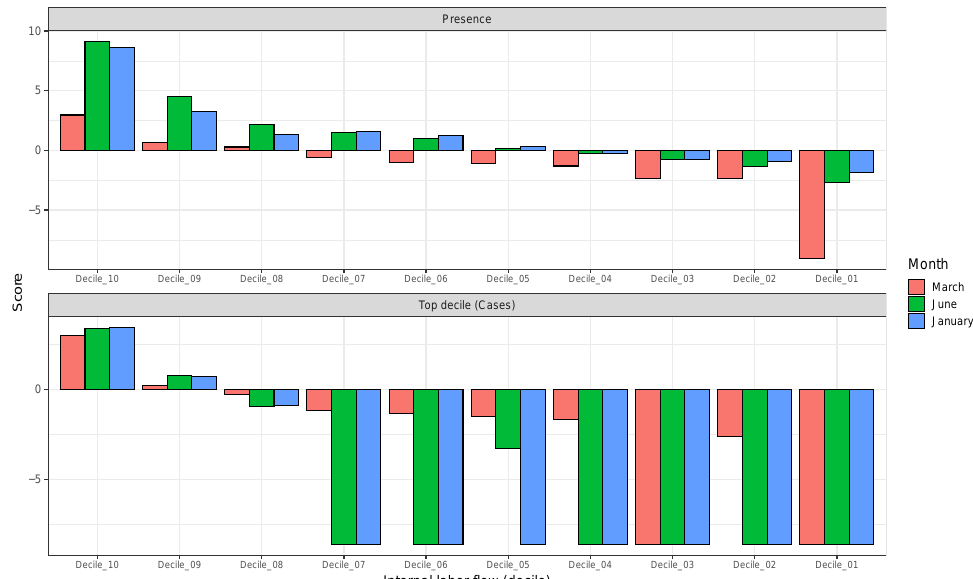
Figure 2. Top : Model scores for the 10 deciles ( Decile i ) of the habitat variable Internal labour flow of the municipality for the model predicting presence of COVID-19 cases; Bottom : Model scores for the 10 deciles ( Decile i ) of the habitat variable Internal labour flow of the municipality for the model predicting the top 10% of municipalities with highest number of cases.